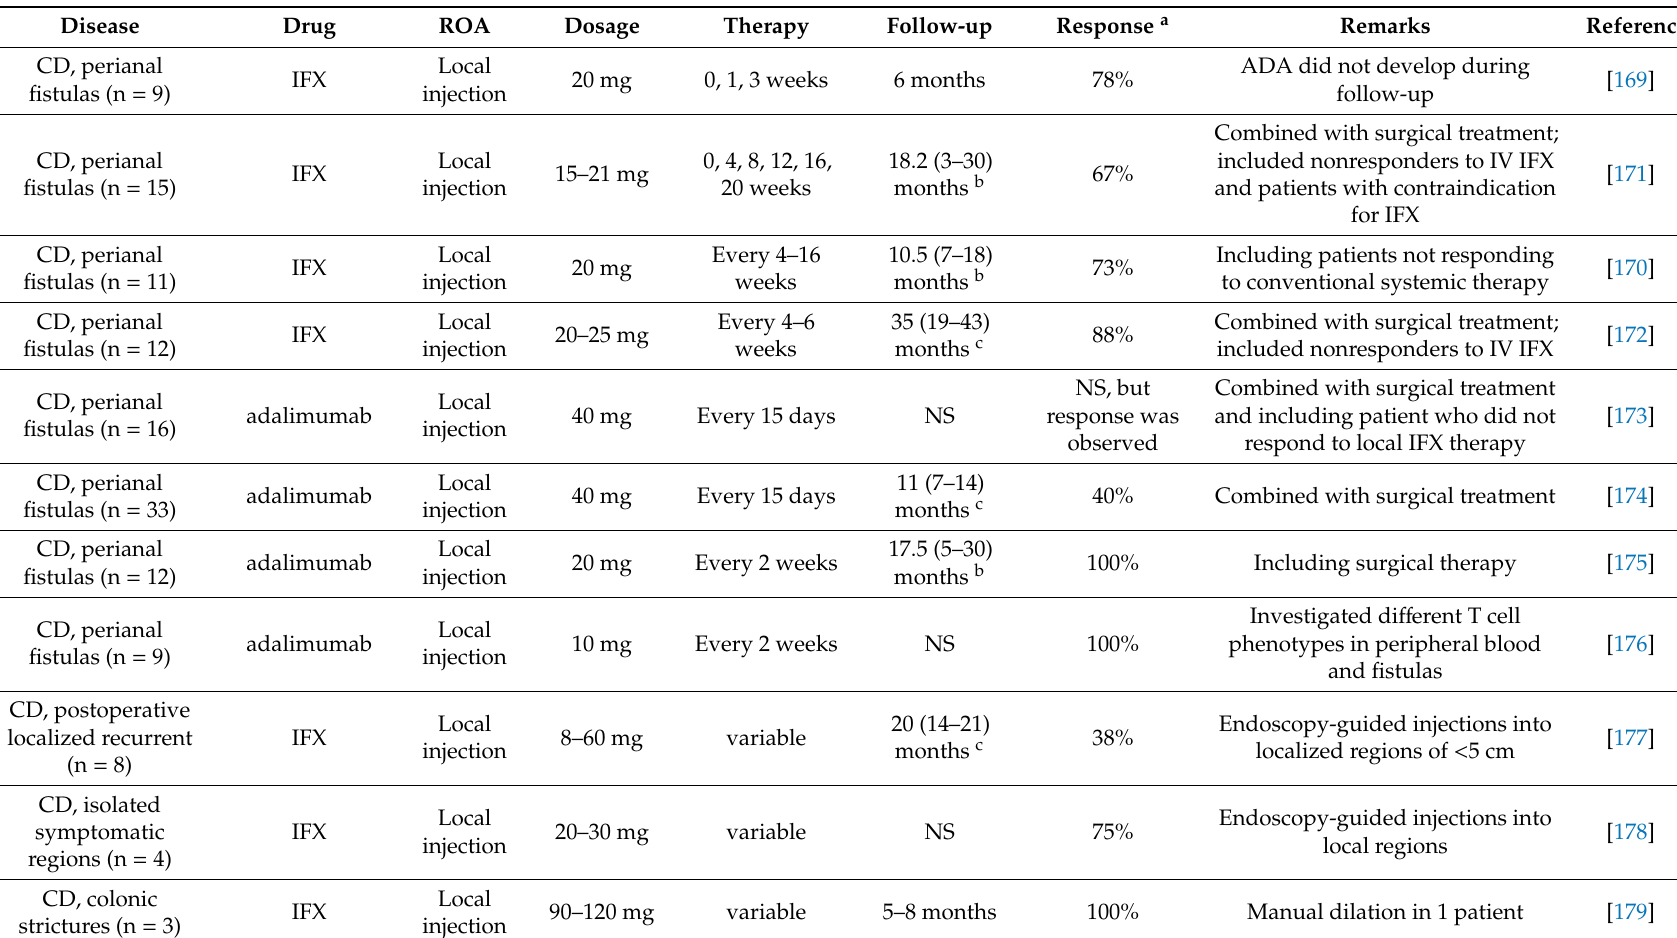
Table 2. Summary of the clinical studies investigating local TNF- α inhibition. Abbreviations: ADA—anti-drug antibodies; IFX—infliximab; NA—not